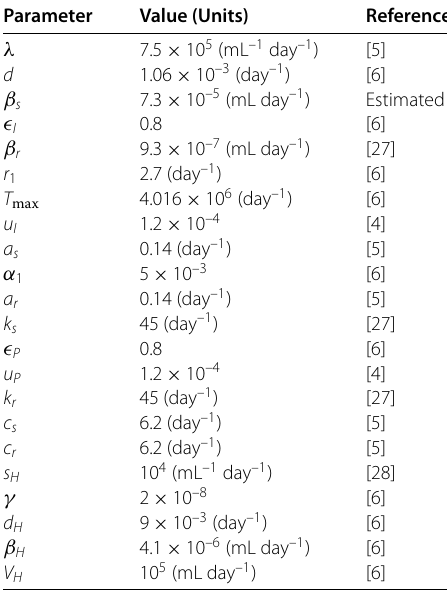
Table 1 Parameters used in the numerical simulations of model